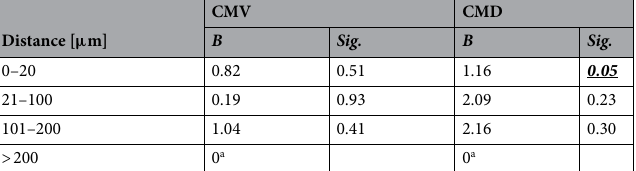
CMV CMD Distance [ µ m ] B Sig. B Sig. 0–20 0.82 0.51